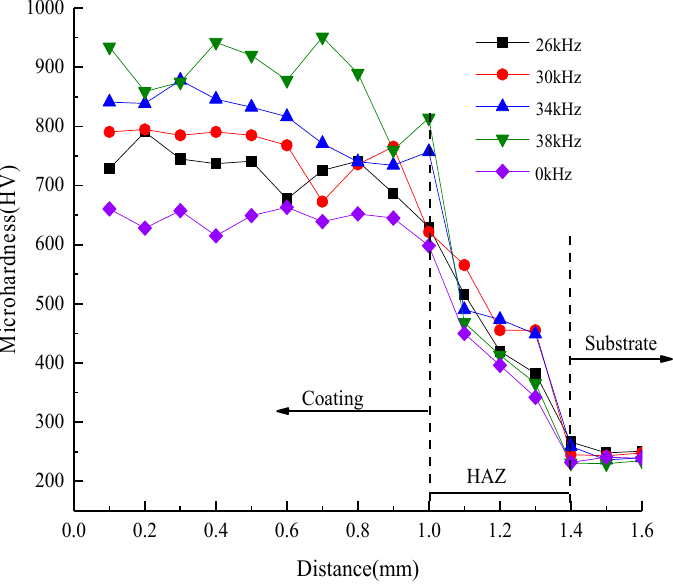
Figure 8. Effect of ultrasonic vibration on cladding layer microhardness.